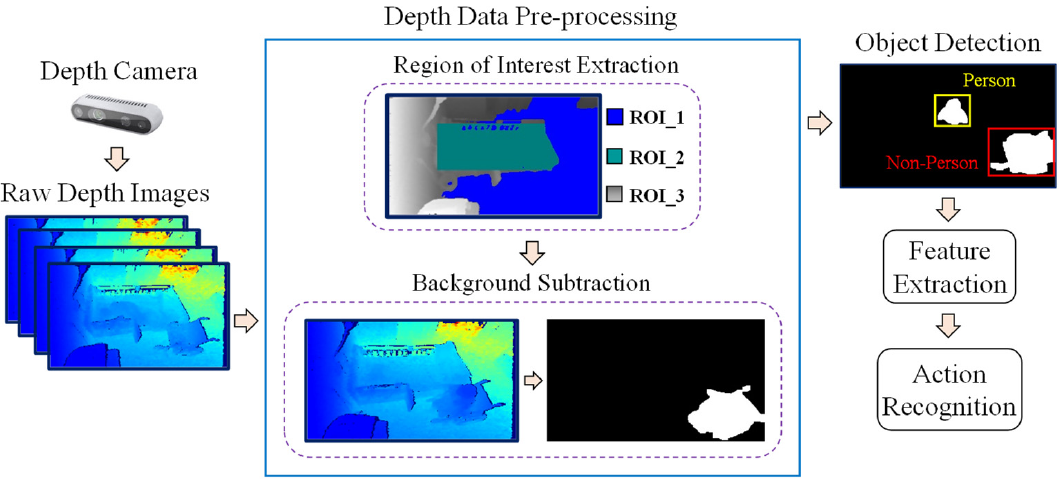
Figure 2. Overview of the proposed system.